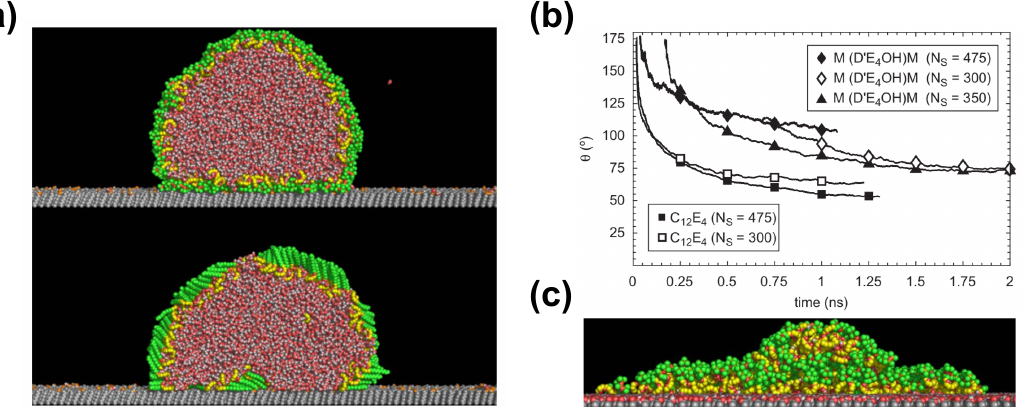
Figure 6. Results from all-atom simulation. ( a ) Final configuration of cylindrical water/trisiloxane and water/alkyl-polyethoxylate droplets on a SAM with a mole fraction of hydroxyl-terminated chains of χ p = 0.25. Reprinted with permission from Ref. [70]; ( b ) Contact angle versus time for different water/surfactant droplets on a graphitic substrate. The droplet size is about 10 4 water molecules. Reprinted with permission from Ref. [70]; ( c ) Equilibrium configuration of water/trisiloxane droplets at 450 K on a hydroxyl-terminated SAM. Reprinted with permission from Ref.